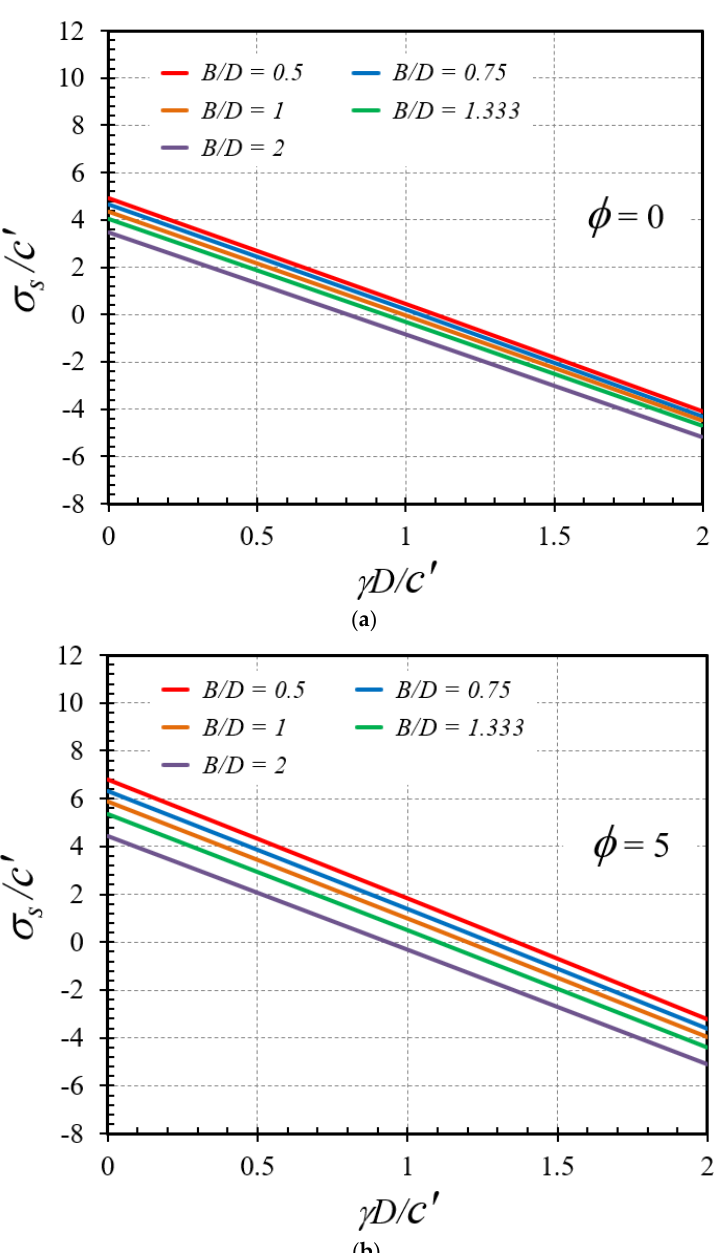
Figure 3. Influence of ϕ on the stability factors σ s /c' of horseshoe tunnels with γ D/c' = 0: ( a ) C/D = 1 and ( b ) C/D = 4.